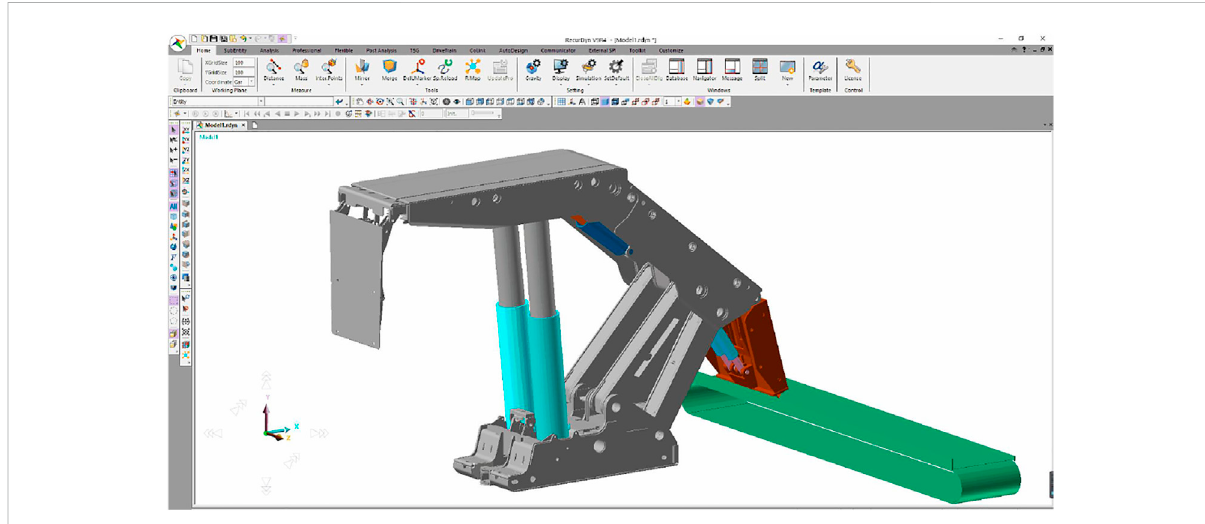
FIGURE 3 Dynamic simulation model of top coal caving support – scraper conveyor.